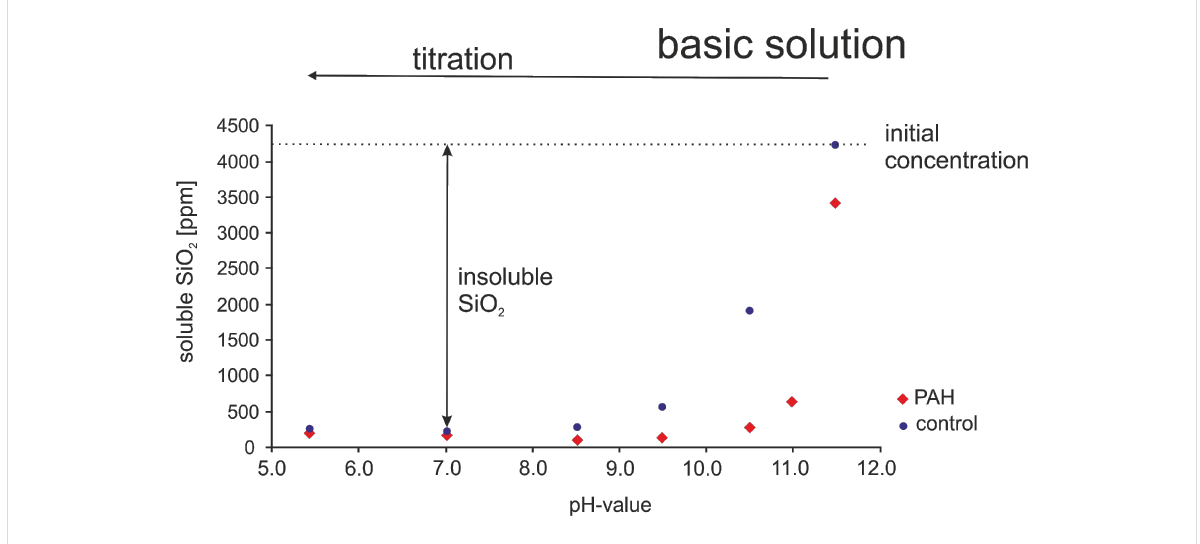
Figure 2: Soluble silicic acid concentration at different pH values in the presence (red rhombuses) and absence (control, blue circles) of PAH. SiO 2 concentration 70 mM (4200 ppm); PAH concencation 0.45 mM. The silicomolybdic acid test reaction was performed 30 min after sample preparation/ pH titration.